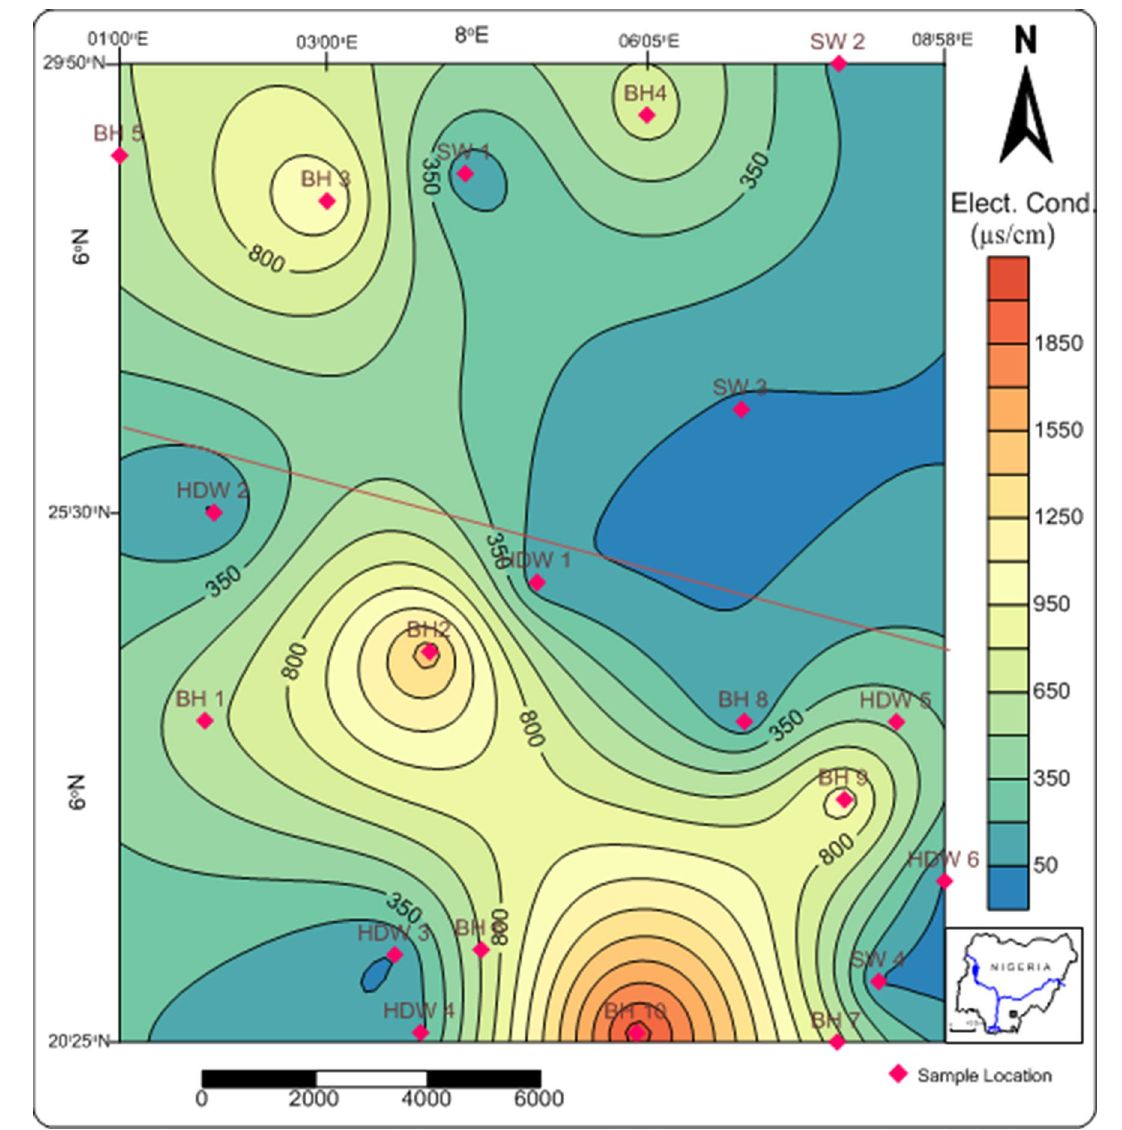
Fig. 24 Map showing the dispersion trend of EC. Note : Perpendicular line indicates groundwater